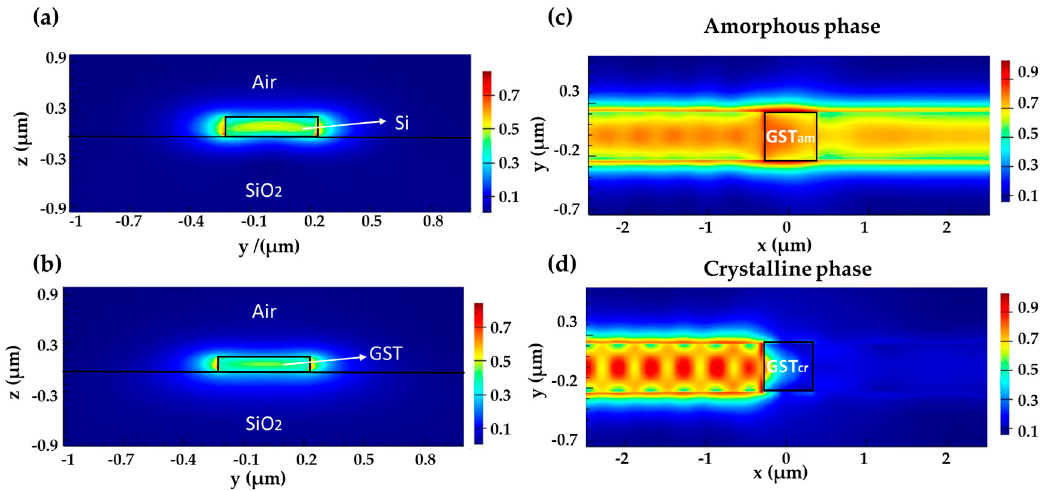
Figure 4. ( a , b ) Electric-field intensity mode profiles of ( a ) silicon waveguide and ( b ) amorphous GST waveguide. ( c , d ) Electric-field intensity distribution in the horizontal plane along the waveguide when GST is at ( c ) the amorphous state and ( d ) the crystalline state.